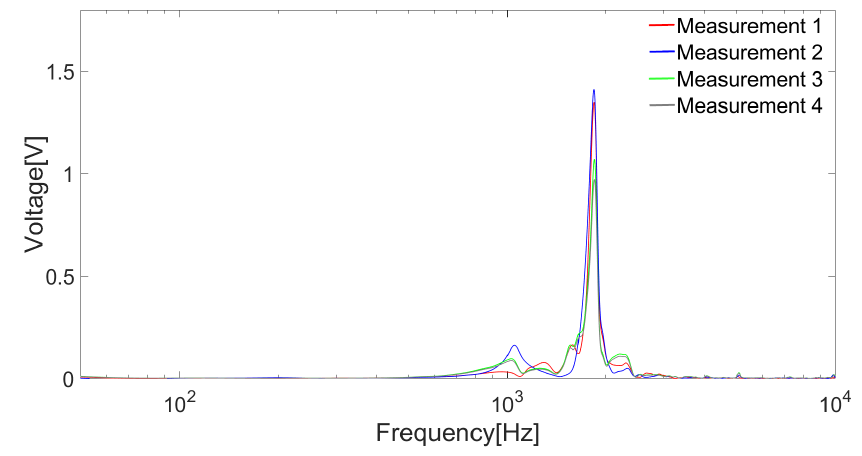
Figure 8. Fourier transform of the open-circuit output voltage for the computation of the resonant frequency of the bimorph beam without tip mass (model